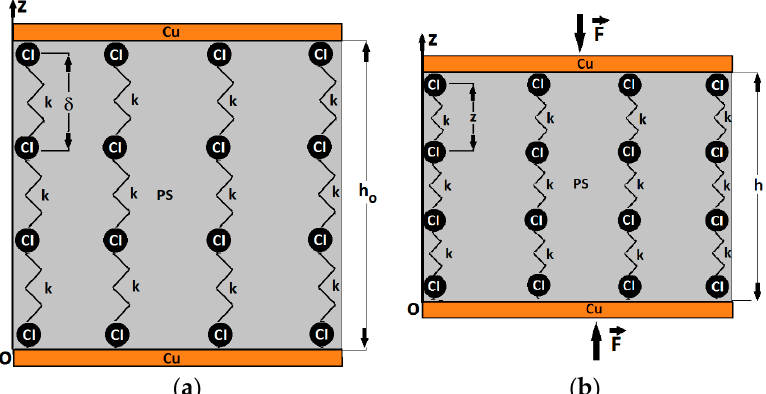
Figure A1. Cross section through MTS: ( a ) in the absence of the magnetic field and the deforming forces, ( b ) after applying the compression force, F ≠ 0 (CI, carbonyl iron microparticles; Cu, copper foil; PS, polyurethane sponge; k, elasticity constant; F, compression force vector, Oz, coordinate axis; δ and z, distances between the mass centers of the CI microparticles for F = 0 and F ≠ 0, respec- tively).